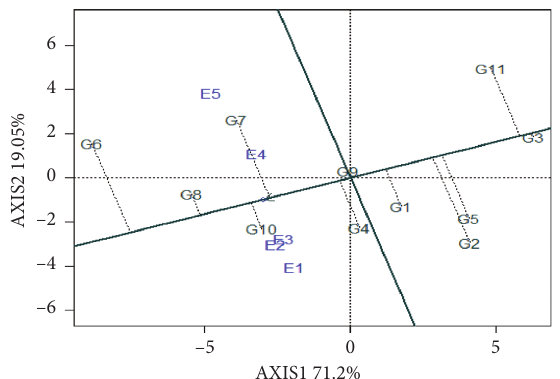
Figure 3: The average-environment coordination (AEC) view of GGE biplot to show the mean performance and stability of the genotypes. The biplots were based on scaling � 0, centering � 2, and SVP � 1. Genotypes: G1 � 95/0194, G2 � 95/18544, G3 � 95/18922, G4 � 95/18949, G5 � 95/19156, G6 � 95/19158, G7 �